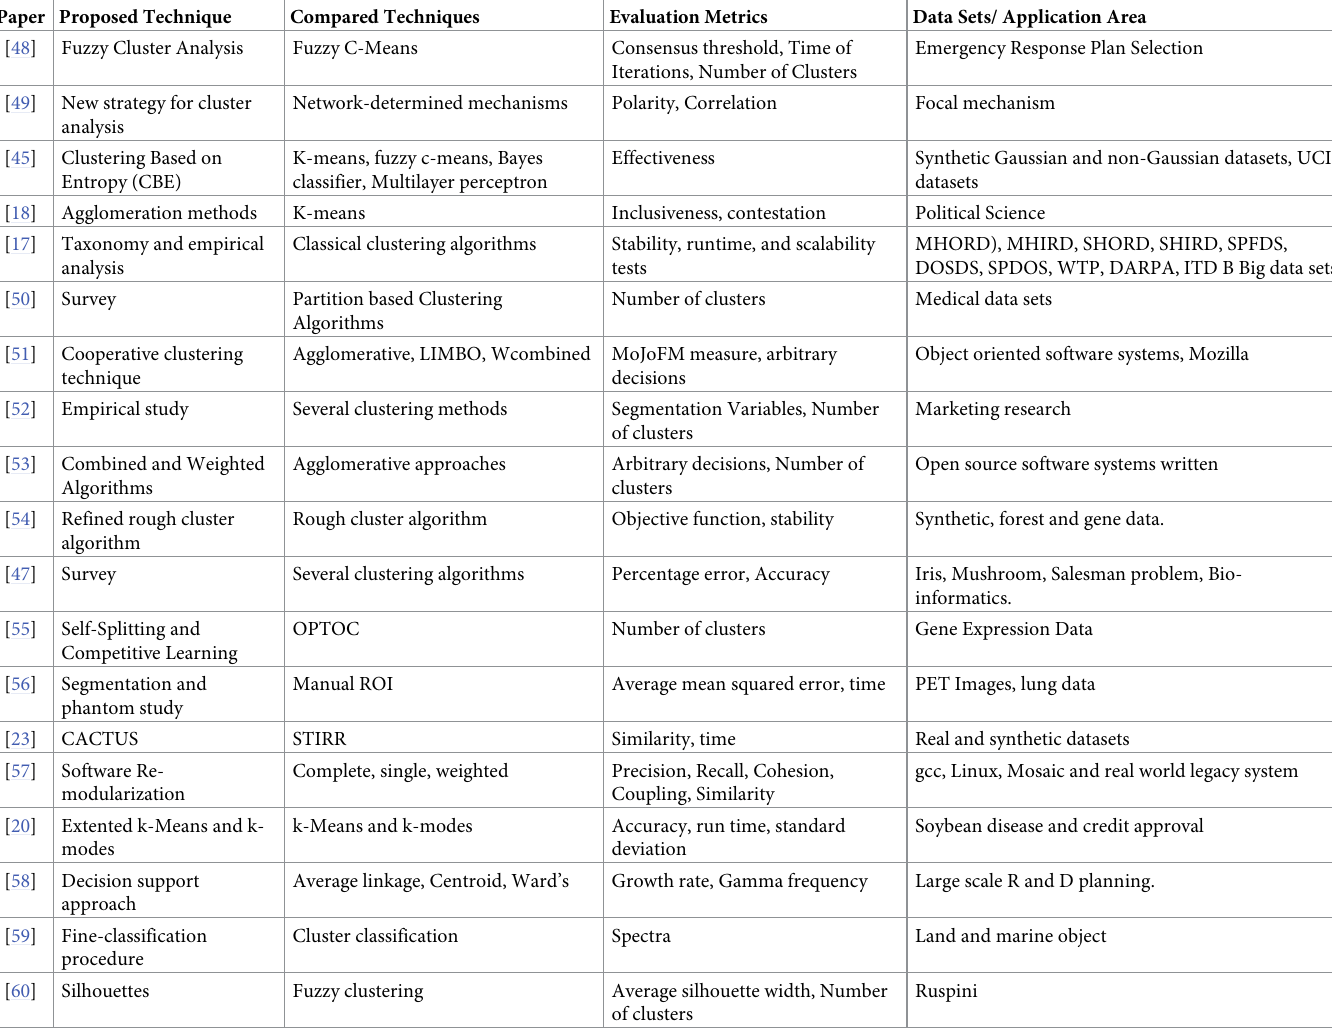
Table 1. Summary of related work on cluster